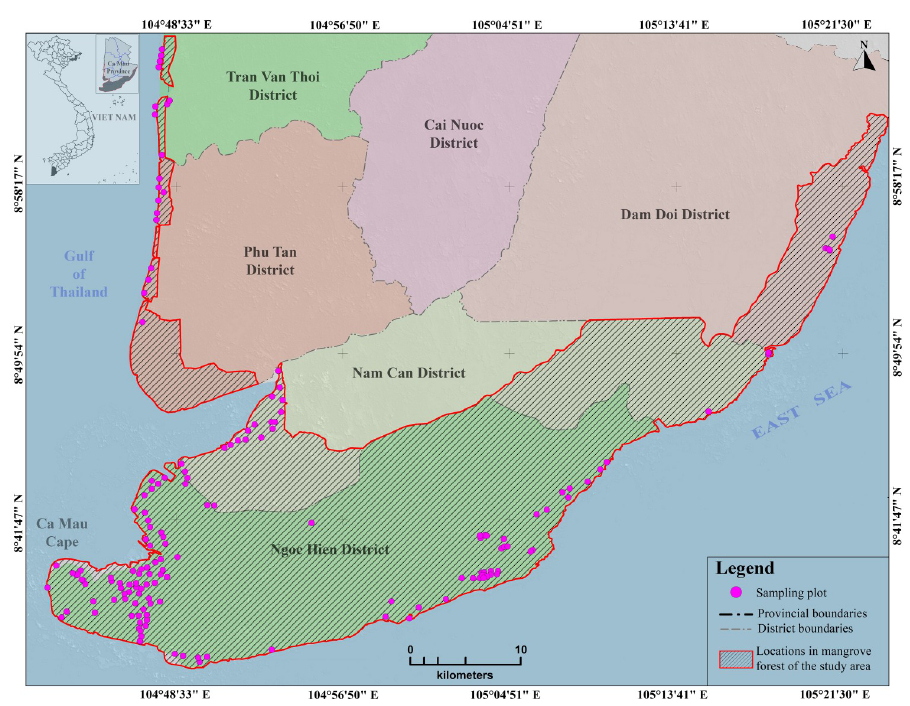
Fig 1. The study area in Ca Mau Province and the distribution of 158 sampling plots are presented spatially on this map. Background spatial data were collected from https://gadm.org/ and processed by the